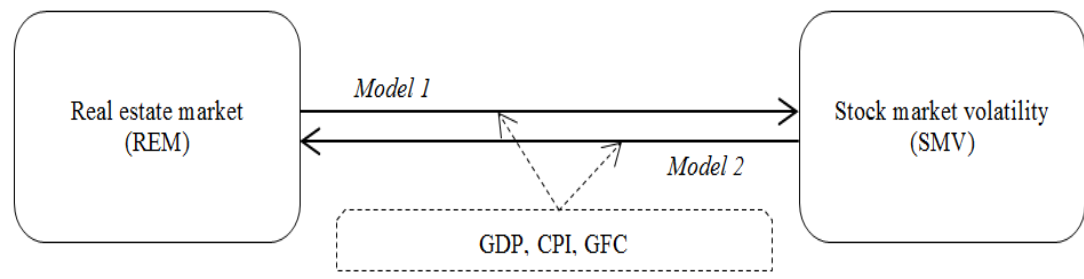
Figure 3. Proposed research